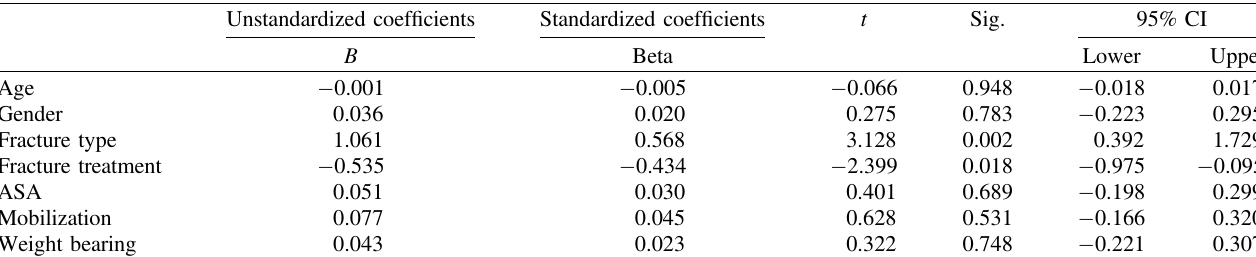
Table 5. Predictors for